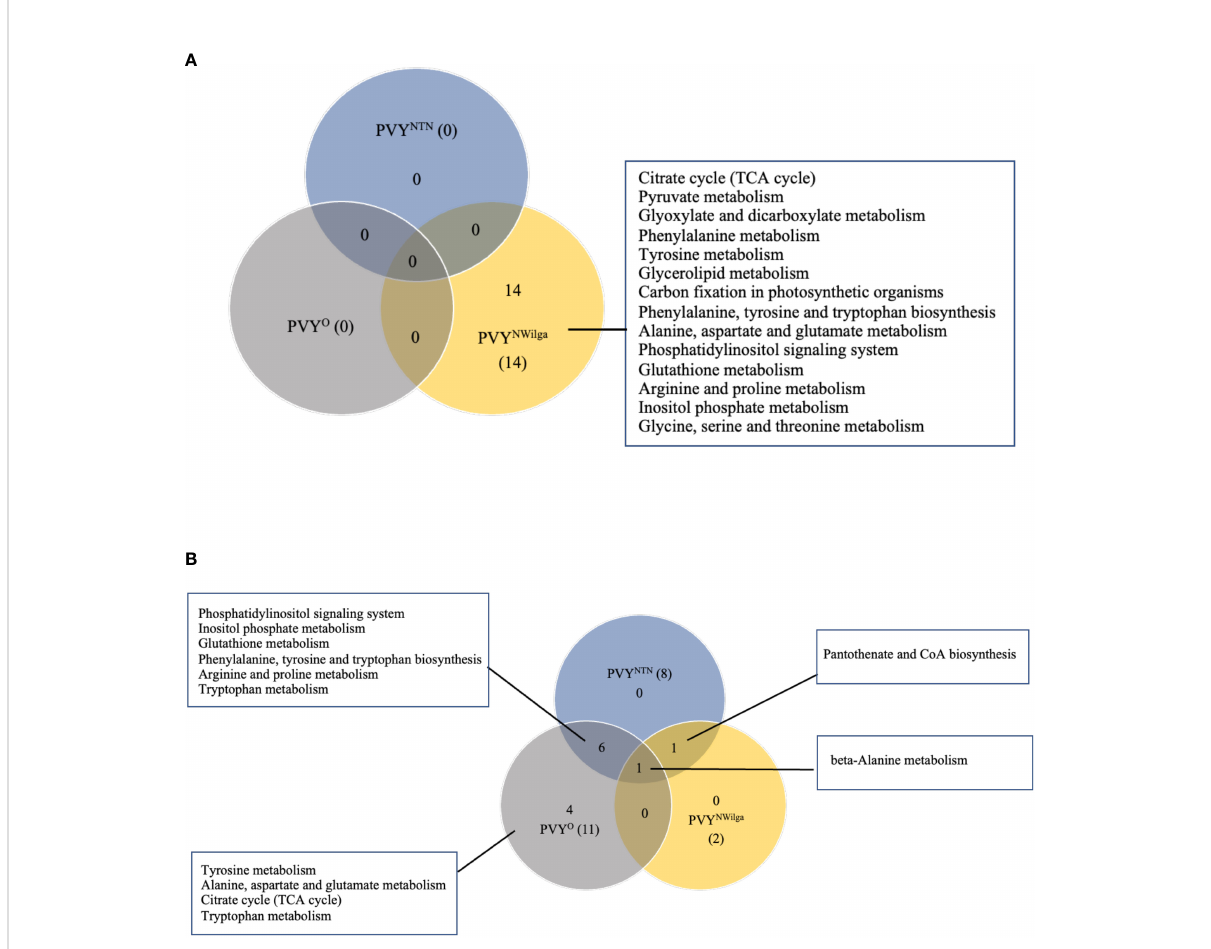
FIGURE 3 Distribution of meaningful metabolic pathways perturbed by local infection of potato with potato virus Y (PVY) (Impact>1). (A) pathway alterations detected in Premier Russet, and (B) in Russet Burbank. Pathway Analysis was performed with default parameters, KEGG pathway database and model metabolome for